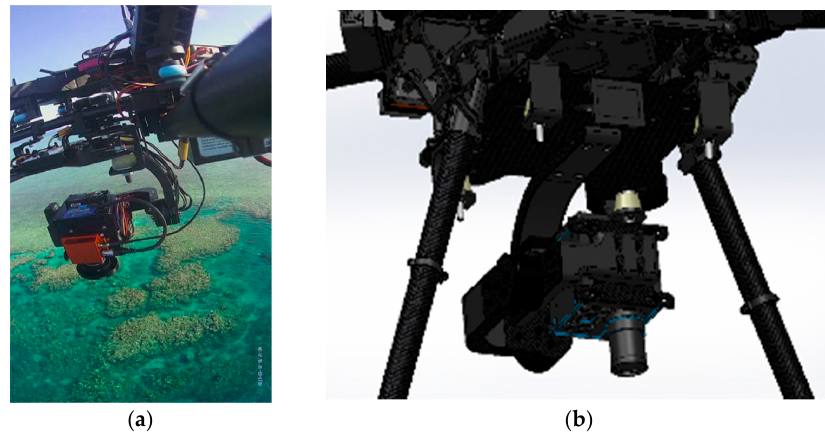
Figure 4. ( a ) Headwall Nano hyperspectral sensor onboard S800 UAV; ( b ) Custom-made 2-axis gimbal hosting the hyperspectral camera (SolidWorks 3D model).